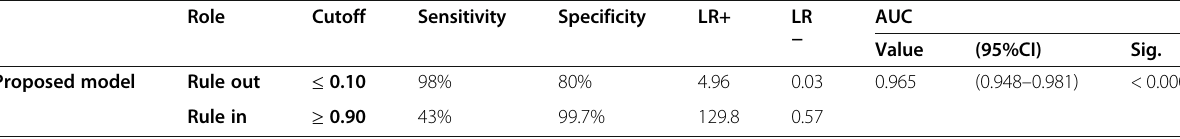
Table 4 Receiver operating characteristics of the proposed prediction